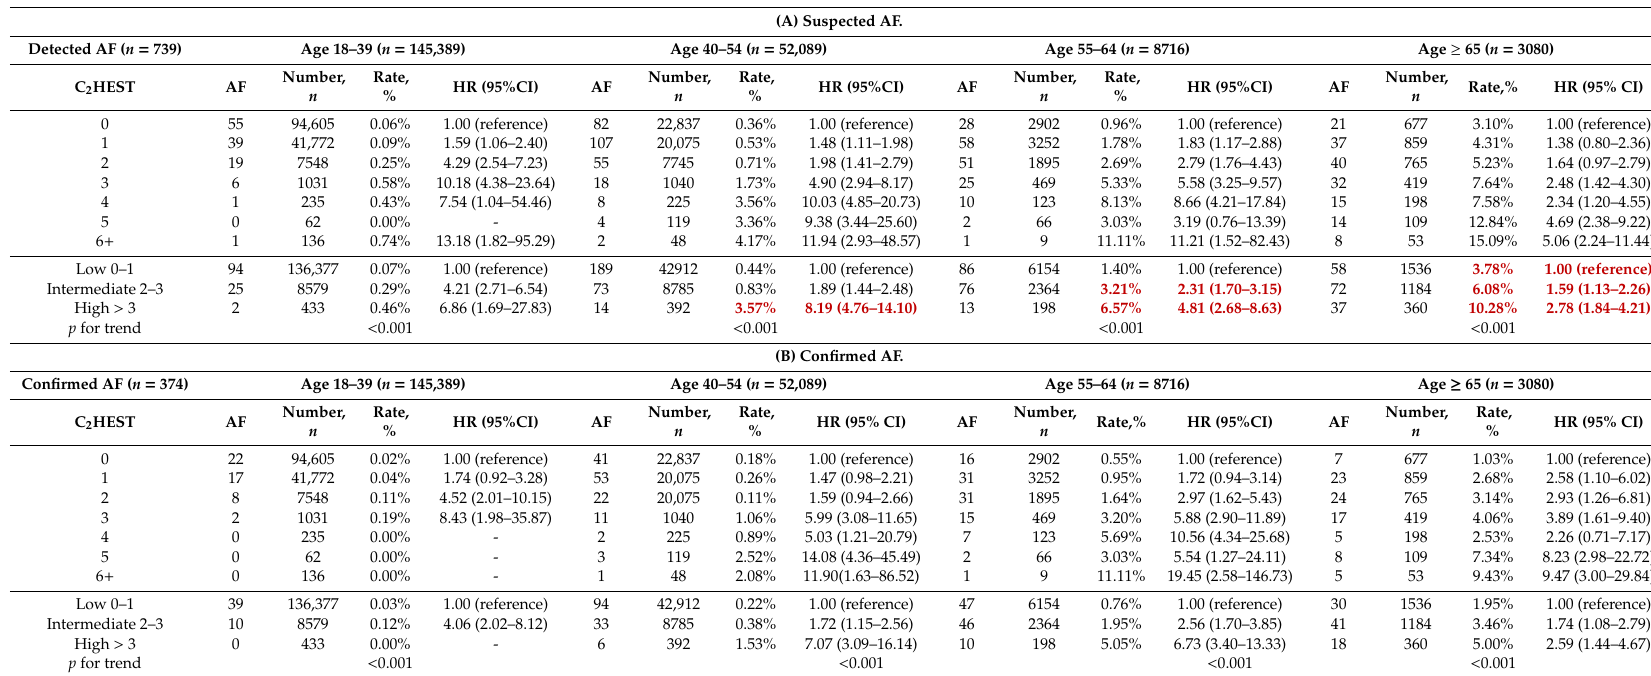
Table 4. Monitored AF event rates, in relation to C 2 HEST score and risk strata, among population age 18–39, age 40–54, age 55–64 and age ≥ 65. ( A ) Suspected AF. ( B ) Confirmed AF.